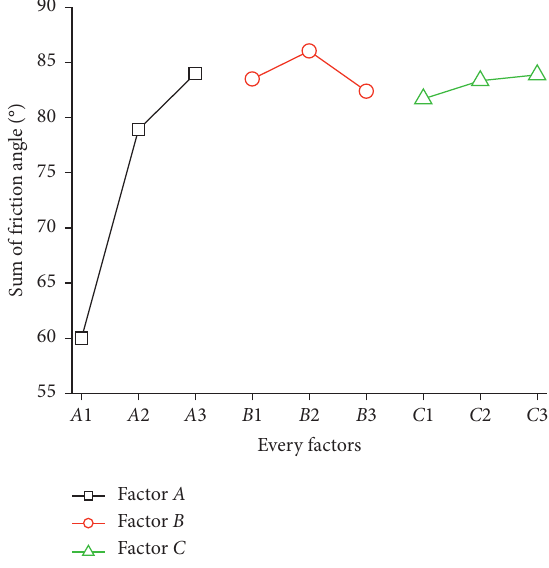
Figure 3: Friction angle of trend diagram. Table 11: Elastic modulus of relative error